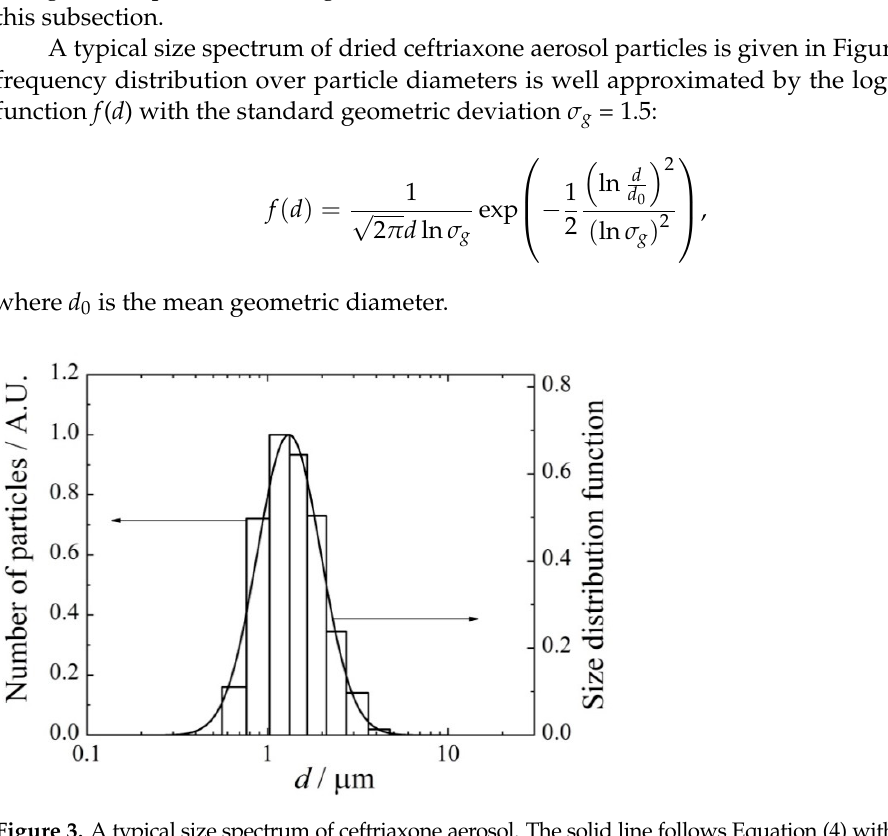
Figure 3. A typical size spectrum of ceftriaxone aerosol. The solid line follows Equation (4) with σ g =